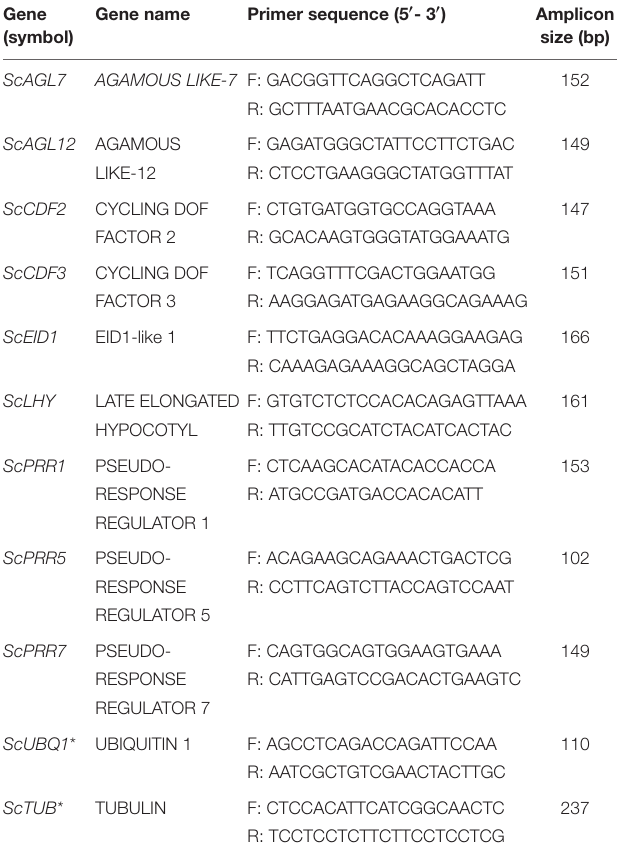
TABLE 1 | Sugarcane putative photoperiodic response and flowering time genes selected for gene expression analysis by RT-qPCR using mature and spindle leaves collected in the seventh and 13th